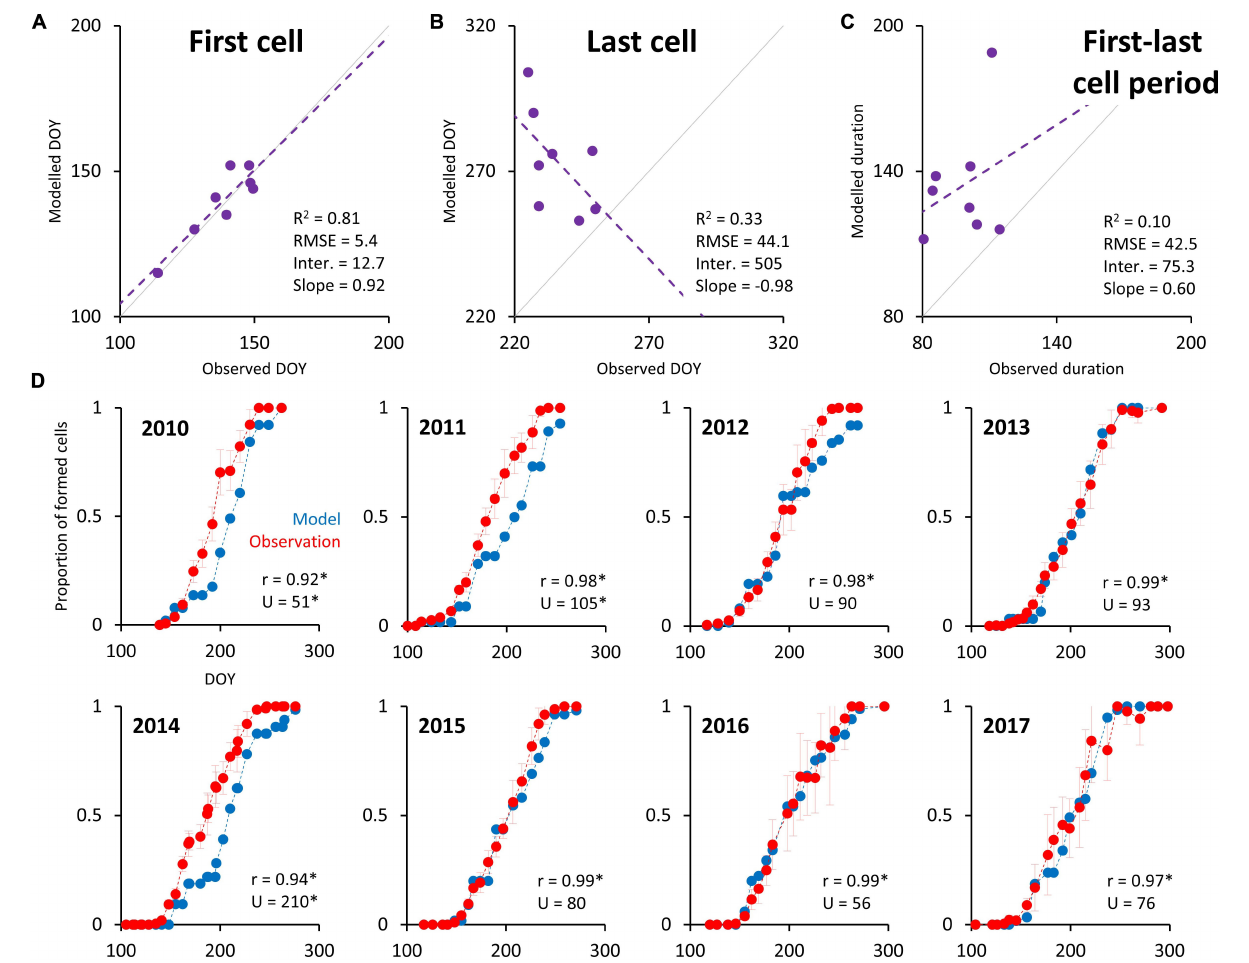
FIGURE 6 | Scatterplots between simulated and observed dates of the appearance of the first (A) and the last (B) differentiating cell in the radial file, and between simulated and observed durations of the period between the first and the last appearance of enlarging cell (C) . Intra-annual progress of increasing number of simulated and observed differentiating cells (D) . Gray lines in panels (A–C) indicate 0–1 relationship and dashed lines indicate least-square regression with parameters shown in the bottom left corners. Error bars around observation points in panel (D) represent 95% confidence intervals. r and U in panel (D) indicate correlation coefficient and statistics of Mann–Whitney U test between both lines, respectively. Asterisk indicates statistically significant statistics ( p -value <